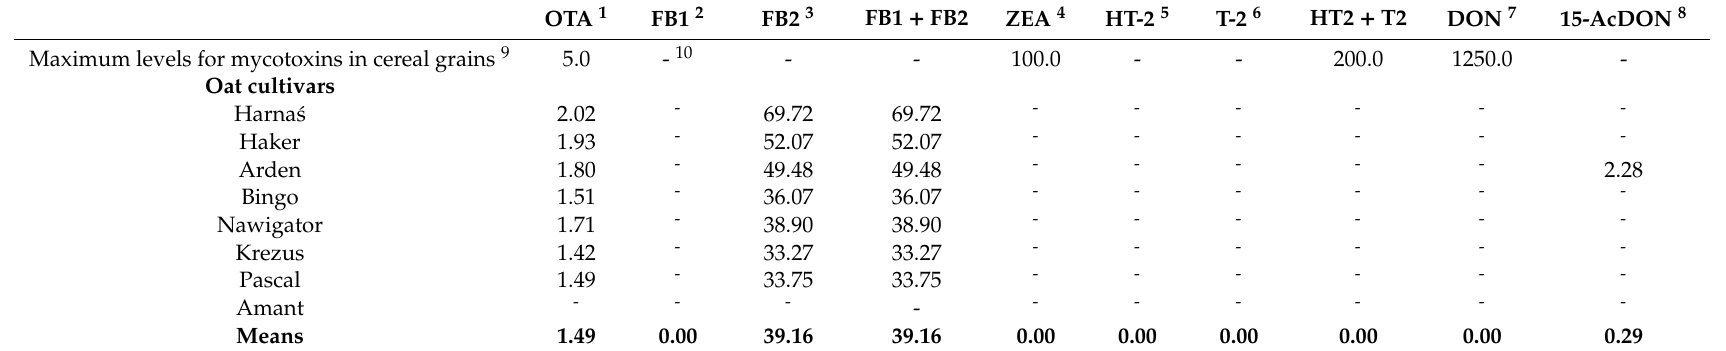
Table 8. Concentrations ( µ g kg − 1 ) of mycotoxins found in grains of 8 oat cultivars grown organically in the controlled field trial in